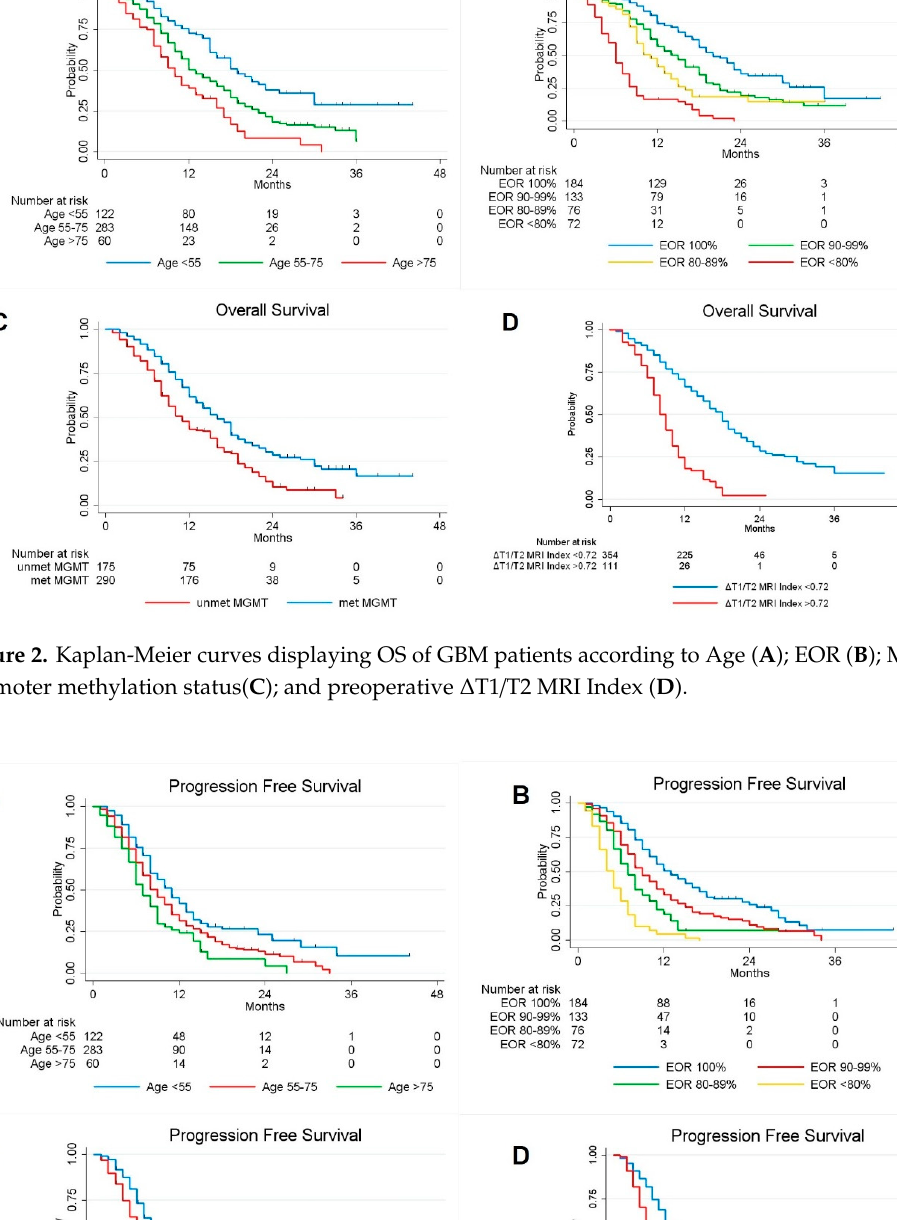
Table 2. Univariate and Multivariate Analysis of PFS in GBM patients.